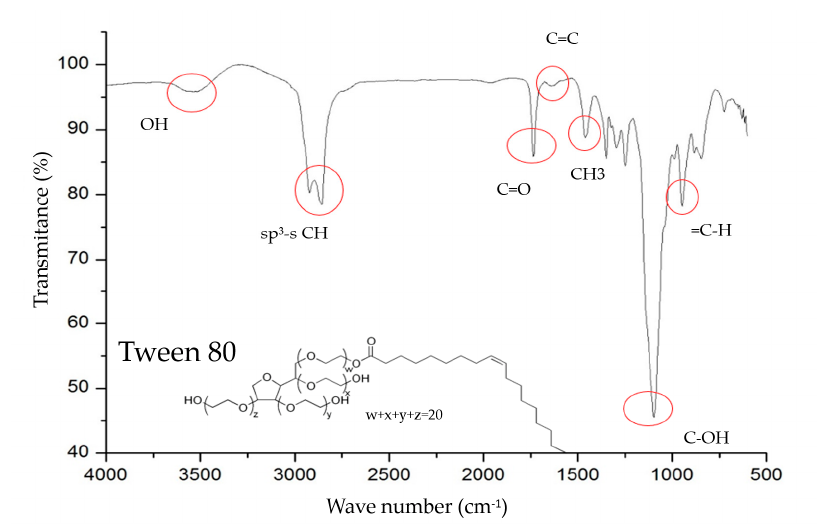
Figure 11. Infrared absorption spectrum of Tween 80. The infrared spectrum of the microemulsion, composed of glycerol, water, Tween 80, and pine oil, showed two signals referring to the C ‐ OH stretch of a primary and secondary alcohol, at 1108 cm − 1 and 1039 cm − 1 , overlapping bands in the region from 1460 cm − 1 to 1207 cm − 1 referring to C ‐ OH absorptions, CH2 deformation, methyl, and C=C stretching, a signal in 1649 cm − 1 referring to the carbonyl (C=O) of ester, sp 3 ‐ s stretching of aliphatic CH at 2928 cm − 1 (asymmetric) and 2884 cm − 1 (symmetric), and an OH stretch at 3340 cm − 1 (Figure 12).